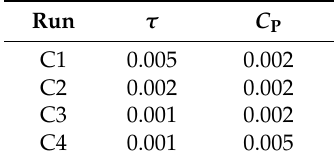
Table 1. Parameters used for conventional FRP.